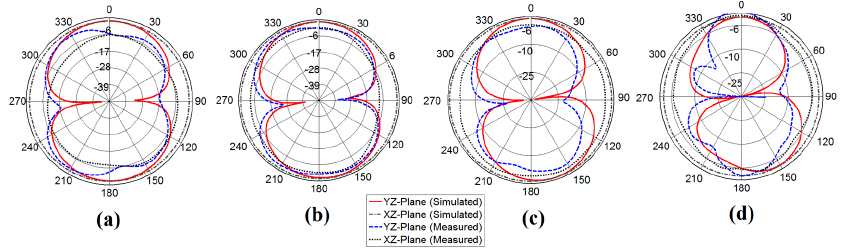
Figure 11. Simulated vs. measured radiation pattern of the proposed antenna ( a ) 3.8 GHz ( b ) 4.9 GHz ( c ) 6.24 GHz ( d ) 8.15 GHz.